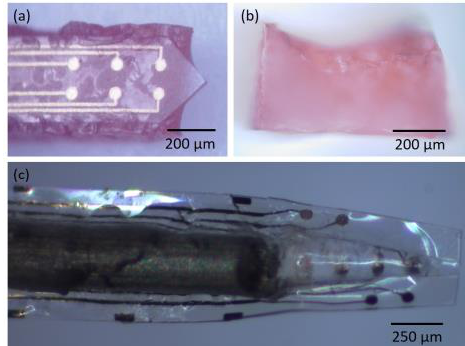
Figure 6. Example of a coating and insertion shuttle solution. Flexible Parylene probe coated in silk for temporary stiffening during insertion: top view ( a ), and cross-sectional view ( b ). Bare probe is 225 µm wide and 20 µm thick, with silk coating dimensions of probe increase to 350 µm wide and 236 µm thick, an 18-fold increase in cross-sectional area. Reproduced with permission from [126]. ( c ) Parylene probe with pocket fed with a 250-µm diameter tungsten push rod serving as a temporary insertion aid, removed after probe implantation. Bare Parylene probe is 450 µm wide and 5 µm thick. Insertion shuttle results in a 70-fold increase in cross-sectional area. Reproduced with permission from Brian J. Kim.